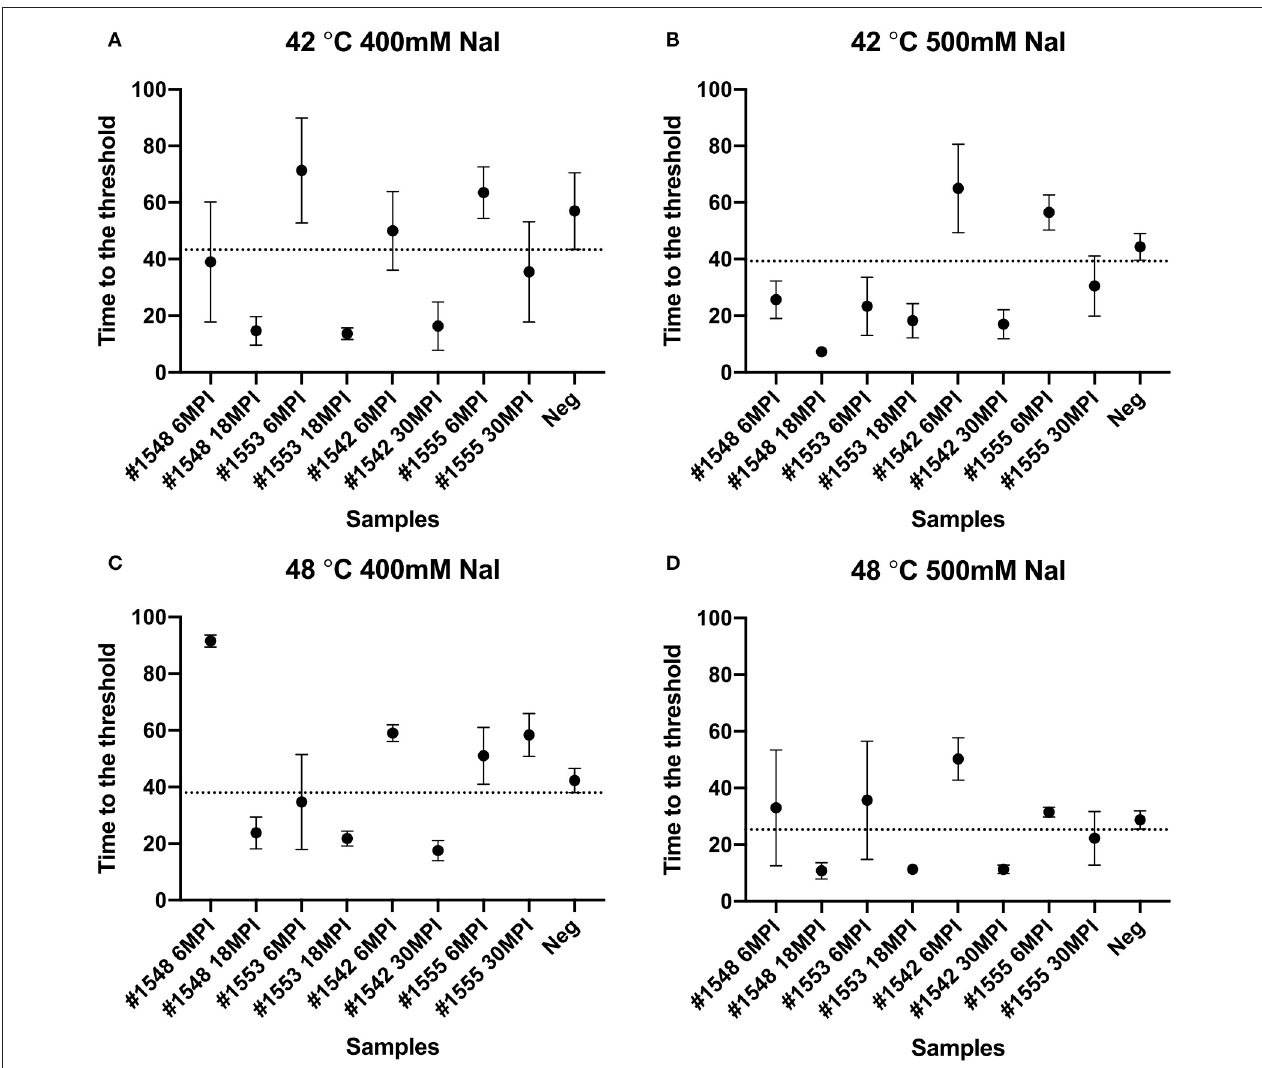
FIGURE 8 | Lag time analysis of RT-QuIC reactions seeded with biopsy fecal homogenates from preclinical white-tailed deer in the presence of NaI. Reactions conditions for each sample are followed as (A) 400mM NaI at 42 ◦ C, (B) 500mM NaI at 42 ◦ C, (C) 400mM NaI at 48 ◦ C, and (D) 500mM NaI at 48 ◦ C. Circles represent the mean and bars represent SD of four replicate reactions. The horizontal line is the